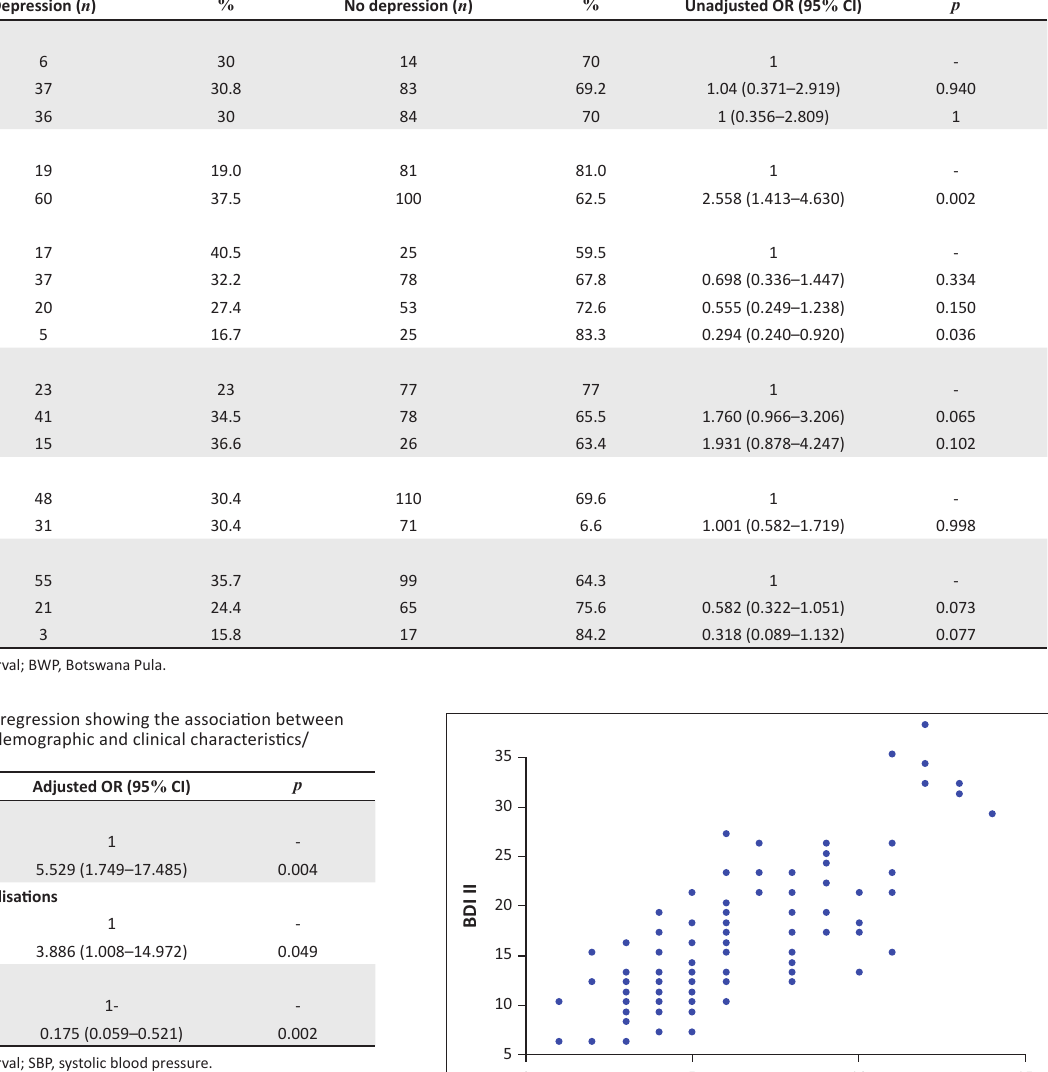
TABLE 5: The association between depression (using Patient Health Questionnaire-9) and socio-demographic characteristics. Demographics